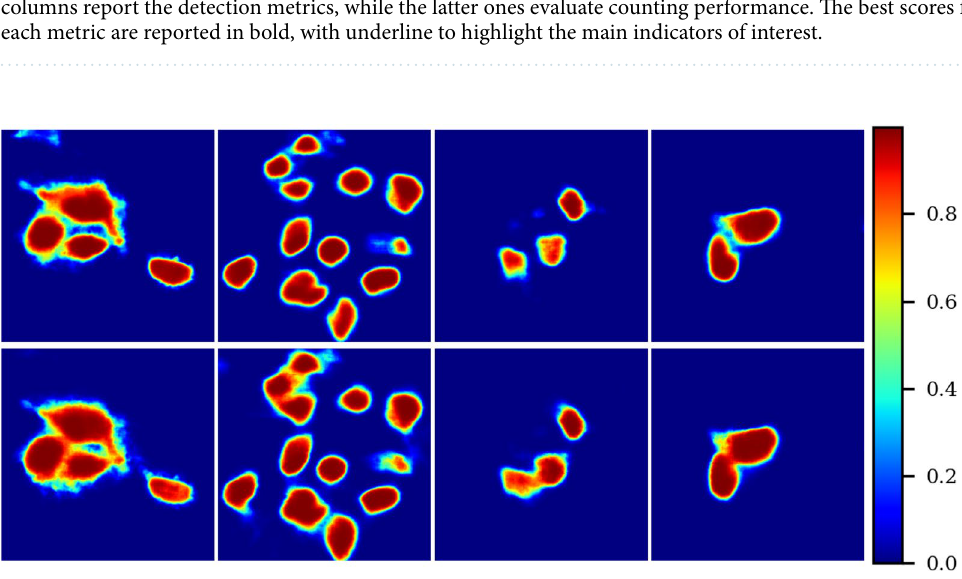
Figure 6. Weight map effect. Predicted heatmaps obtained with c-ResUnet (top row) and c-ResUnet (no